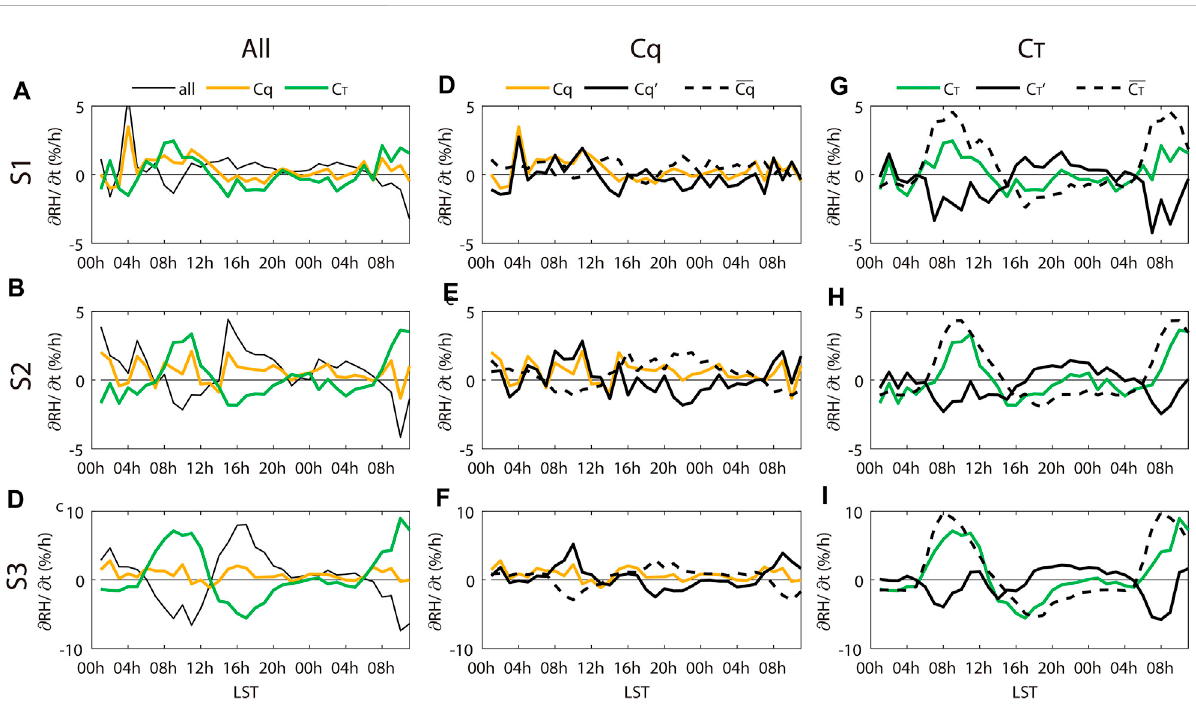
FIGURE 6 Composite z RH/ z t (black curve in the left column; %/h), contribution of q (C q ; yellow curve in the left and middle columns; %/h), and temperature(C T ;greencurveintheleftandrightcolumns;%/h)atstationsS1,S2,andS3forallSFPevents.Thetermsarecalculatedusinghourlydata at stations S1 (top row), S2 (middle row), and S3 (bottom row) based on Formula 3. In the middle column, C q is decomposed to a mean diurnal cycle (C q ; dashed curve) and anomaly (C ′ q ; solid curve). In the right column, C T is decomposed to a mean diurnal cycle (C T ; dashed curve) and anomaly (C ′ T ; solid curve). The time period starts from day 0 00 LST to day+1 12